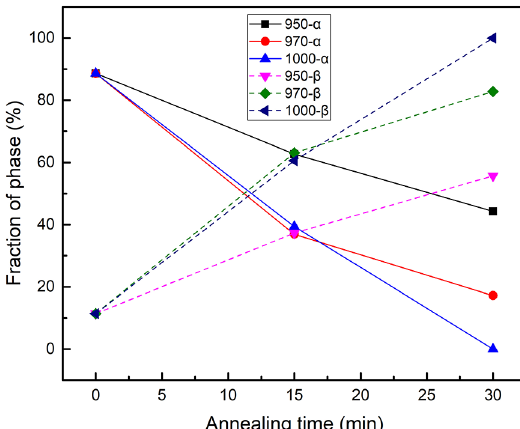
Figure 5. The fractions of α and β phases as a function of annealing time at different annealing temperatures.